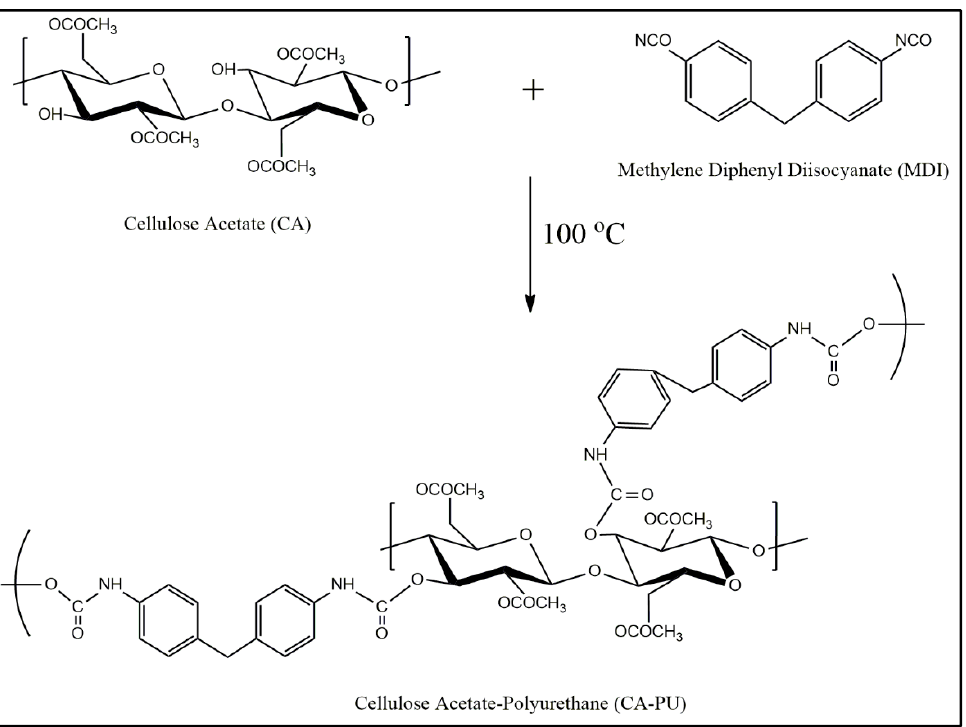
Figure 2. Cellulose acetate and methylene diphenyl diisocyanate (MDI) was reacted to produce the cellulose acetate–polyurethane (CA–PU) film. Polymers 2020 , 12 , x FOR PEER REVIEW